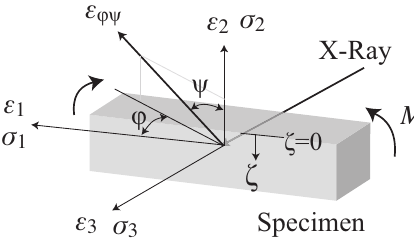
Figure 12. Relationship between directions of measured strain and bending specimen axis.